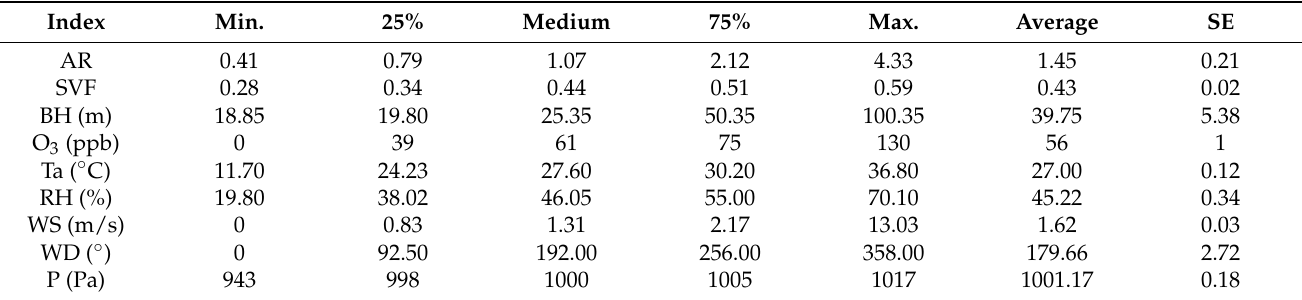
Table 1. Statistical characteristics of urban street morphology, ozone, and microclimate conditions at 1.5 m.